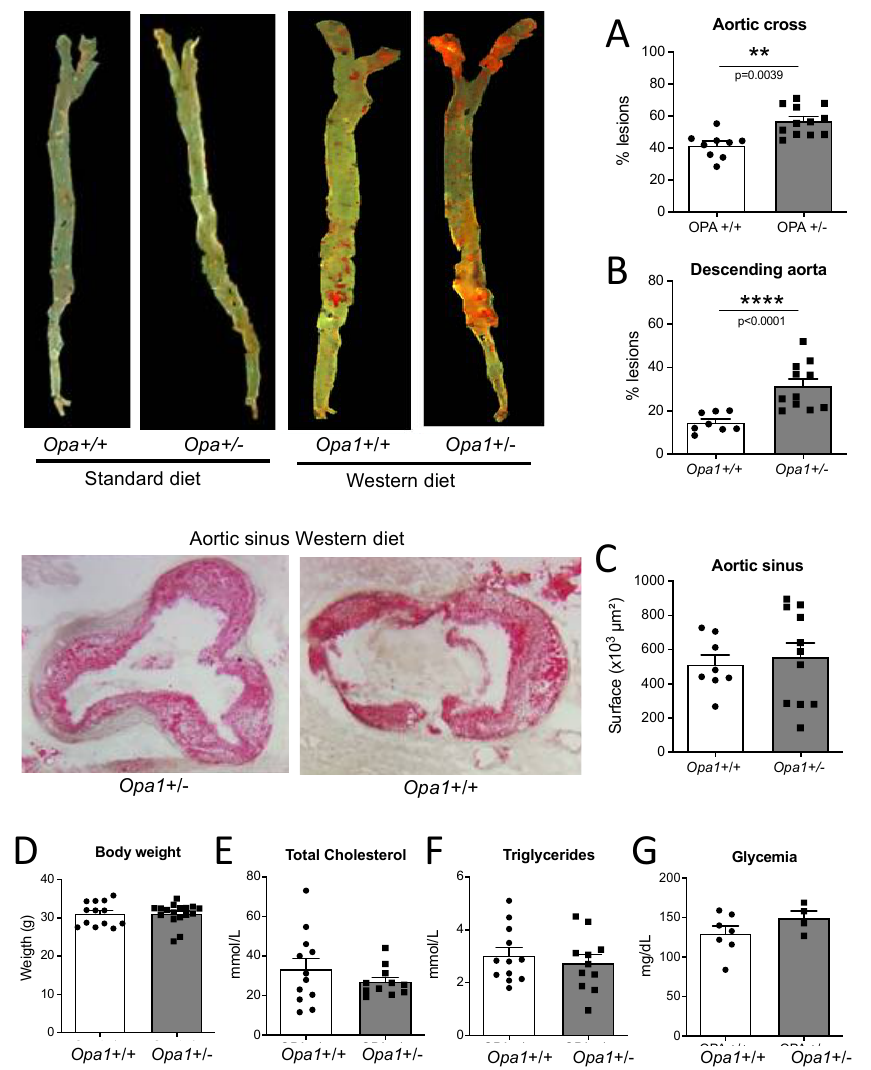
Figure 8. Consequence of Opa1 deficiency in endothelial cells on plaque formation. Opa1 + / + and Opa1 + / − mice that were three months old were fed with an atherogenic diet (Western diet) and compared to Opa1 +/+ and Opa1 +/ − mice fed with a standard diet. After 4 months the aorta was collected from the sinus to the iliac bifurcation and stained with Oil red-O. Lipid deposition was quantified in the aortic cross, ( A ), in the descending aorta ( B ) and in the aortic sinus ( C ). Bodyweight ( D ), plasma cholesterol ( E ), triglycerides ( F ), and glycemia ( G ) were measured in each group of mice. Means ± SEM are shown (n = 11 Opa1 +/− and 8 Opa1 +/+ mice per group). ** p = 0.0039 ( A ); **** p < 0.0001 ( B ) and NS ( C – G ), Two-tailed Mann–Whitney test.